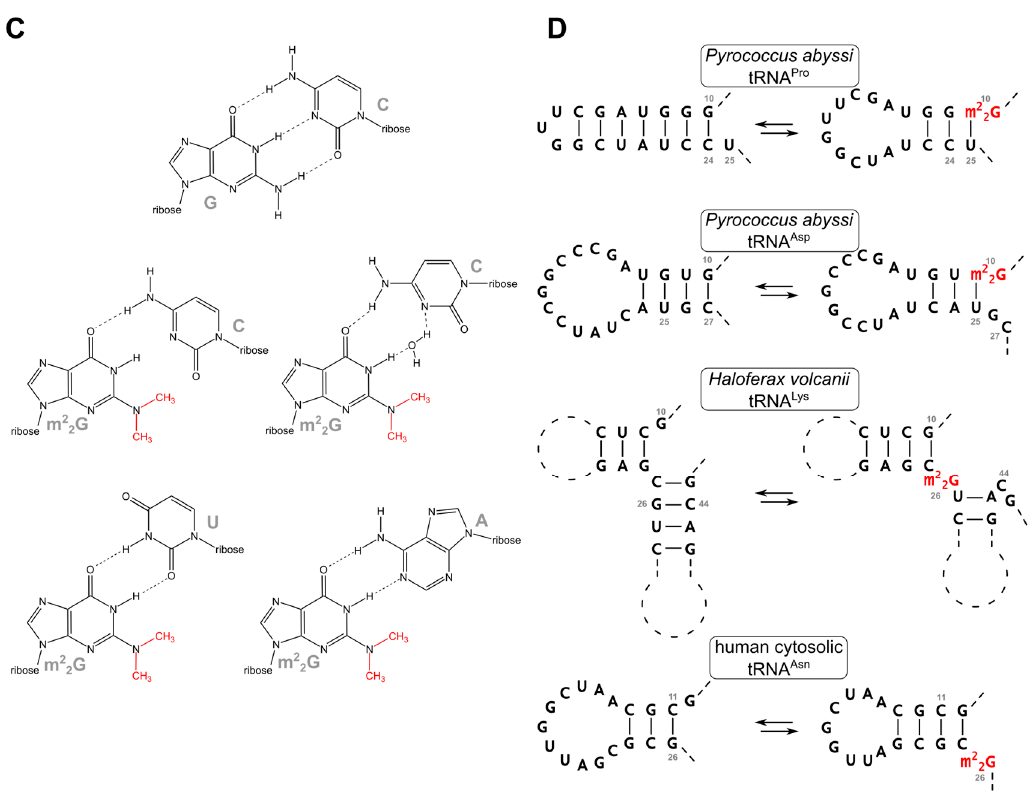
Figure 4. Modifications direct a tRNA secondary structure. ( A ) The in vitro transcript of human tRNA Lys shows an extended hairpin structure due to missing modifications. The introduction of N 1 ‐ methyladenosine (m 1 A) at position 9 interrupts a base pair with U64 and forces the canonical folding of the tRNA. U64 now pairs with A50 [51,52]; ( B ) The unmodified transcript of human mitochondrial tRNA Asp shows an equilibrium between various secondary structures. It is suggested that the natural occurring modification m 1 A9, m 2 G10 and Ψ 27 are important for correct folding. Queuosine at position 34 in the anticodon loop does likely not contribute to the secondary structure [55]. ( A , B ) adapted with permission from Motorin and Helm [40]. Copyright (2010) American Chemical Society; ( C ) The two methyl groups of m 2 2 G at the exocyclic N2 of guanosine create a steric hindrance and preclude base pairing with cytosine. However, the methylations do not alter the base pairing with A or U as the amino group at N2 is not involved in this interplay. An interaction of m 2 2 G with C is possible via a bridging water which leads to a greater distance between the two bases [56]; ( D ) Various examples show the impact of m 2 2 G for a correct tRNA folding. In Pyrococcus abyssi tRNA Pro contains m 2 2 G at position 10, which wobble pairs with U25. A lack of this modification can lead to dramatic misfolding of the D-arm due to an extended D-stem [57]. tRNA Asp of the same organism also contains m 2 2 G10. However, this modification prevents a wrong base pairing with C27, which would lead to an enlarged D-loop [57]. In tRNA Lys of Haloferax volcanii , m 2 2 G can also direct the folding of the anticodon stem by interrupting C25-G45 and G26-C44 base pair which leads to an elongated anticodon and shortened D-stem [56]. A similar example is human cytosolic tRNA Asn . Here, m 2 2 G is found at position 26 and prohibits base pairing with C11